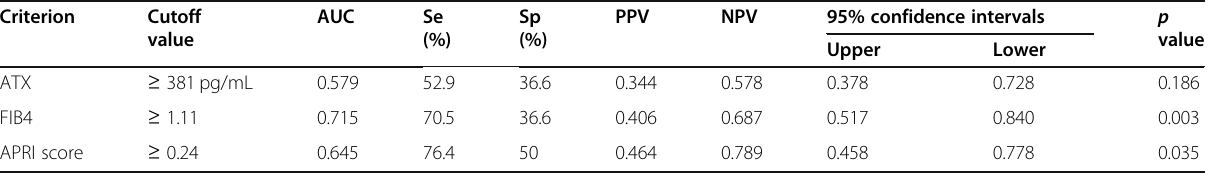
Table 5 The diagnostic performance for the detection of grade F3 – 4 fibrosis at SVR12